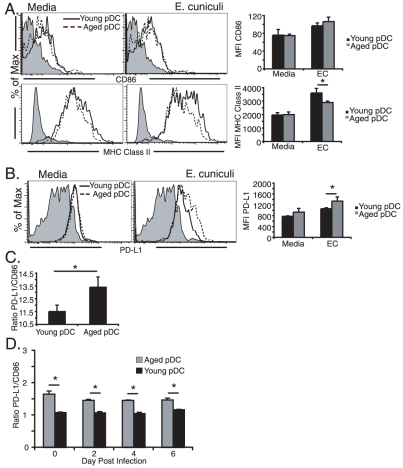
pDC from aged mice express higher PD-L1 than CD86.Sort purified pDC from naïve young and aged mice were plated and cultured in the presence of irradiated E. cuniculi spores and 12 hours later analyzed for maturation. (A) Histograms for (top panels) CD86 and (bottom panels) MHC Class II are shown with mean MFI values. Corresponding bar graphs show the mean ± SD MFI for each marker measured. (B) Histograms for PD-L1 expression by pDC after E. cuniculi stimulation are shown with corresponding bar graph (left) of mean MFI ± SD. (C) Bar graph shows PD-L1/CD86 ratio on young or aged pDC after in vitro stimulation with E. cuniculi. Separately, young or aged mice were inoculated orally with E. cuniculi and splenic pDC assayed ex vivo for PD-L1 and CD86 expression by flow cytometry on days 0, 2, 4 and 6 post infection. (D) Bar graph shows mean ± SD of the PD-L1 to CD86 ratio on pDC from infected mice. Experimental data presented was repeated independently twice. Ex vivo experiments had an n = 4 mice per group. * denotes significance with p<0.05 by Student's t test.